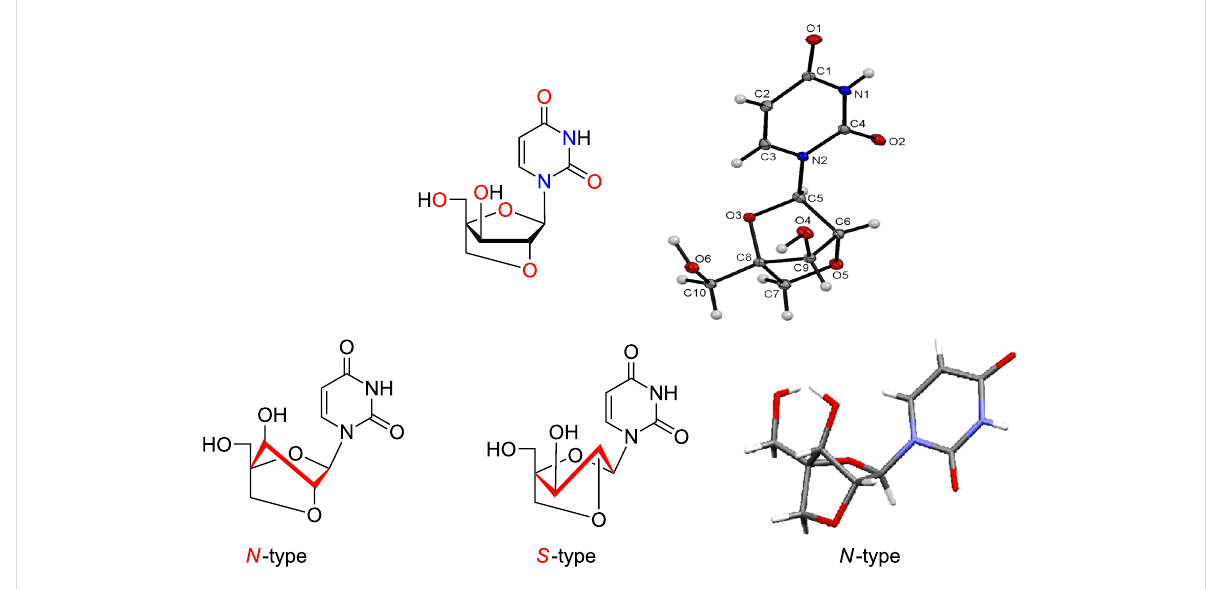
Figure 3: ORTEP diagram and preferential N -type sugar ring puckering of 2 ′ - O ,4 ′ - C -methylene-xylouridine ( 14 ).